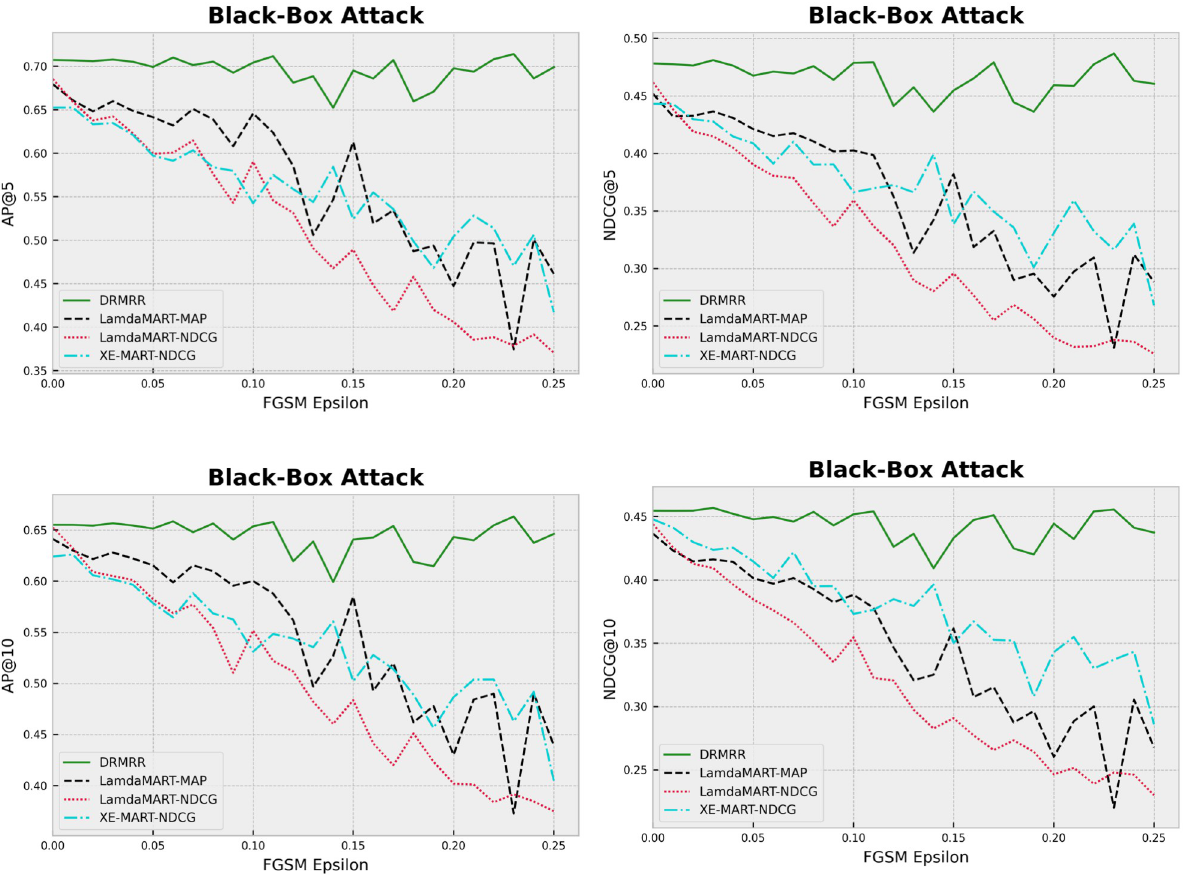
Fig 4. The impact of black-box adversarial perturbation on the performance of ranking models.